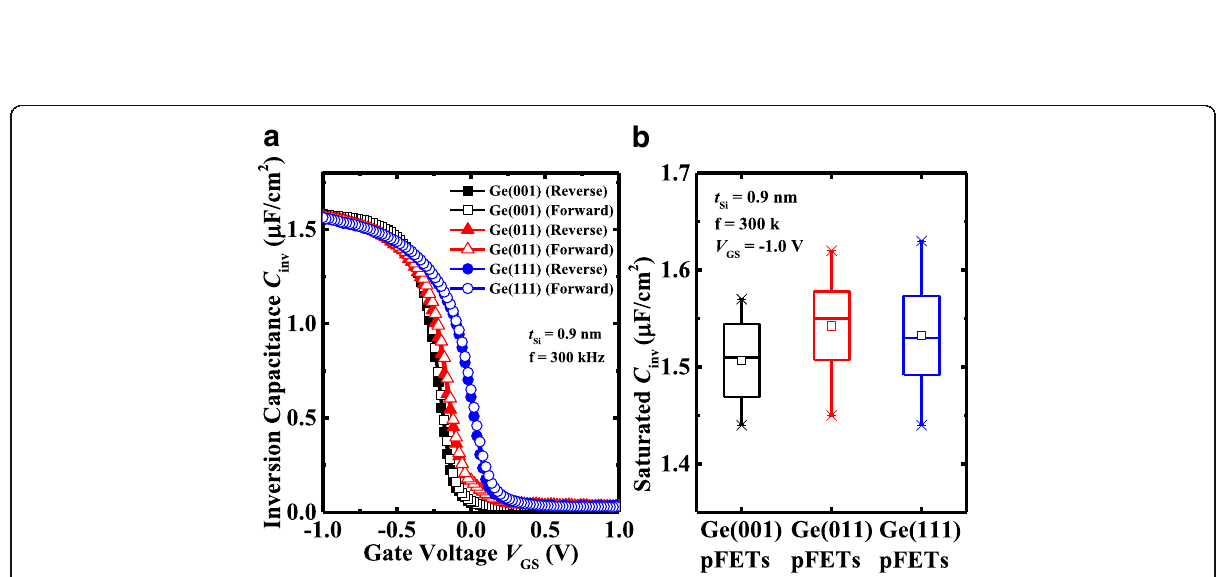
Fig. 5 a Comparison of inversion C inv - V GS curves among the Ge pMOSFETs with 0.9 nm t Si on different orientations. Both forward and reverse sweeping are shown. b Statistical plots for the saturated C inv of the devices showing the negligible differences in C inv in the inversion